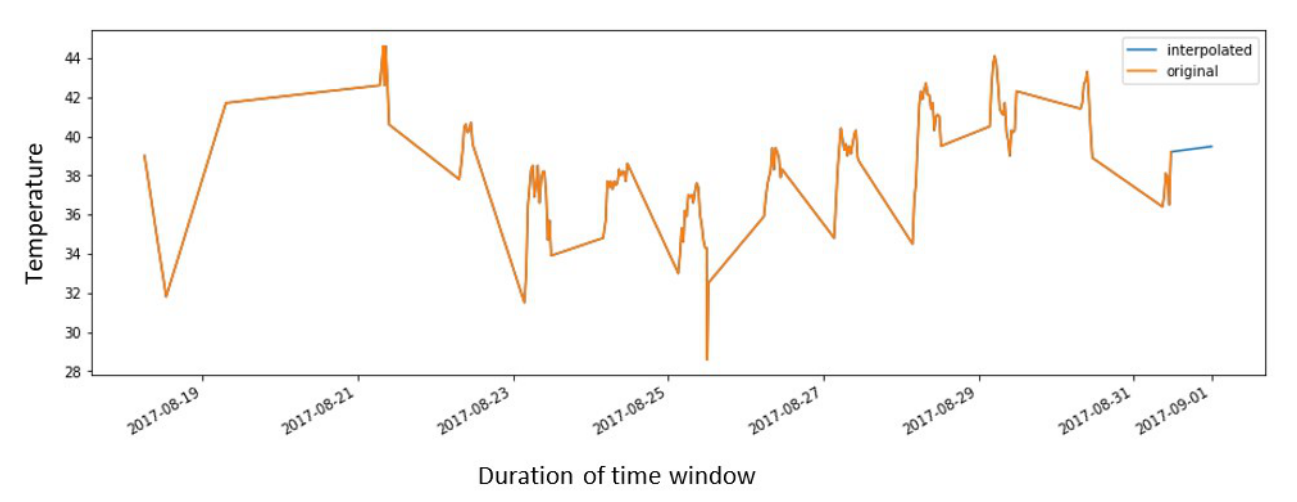
Figure 4. Plot of data after